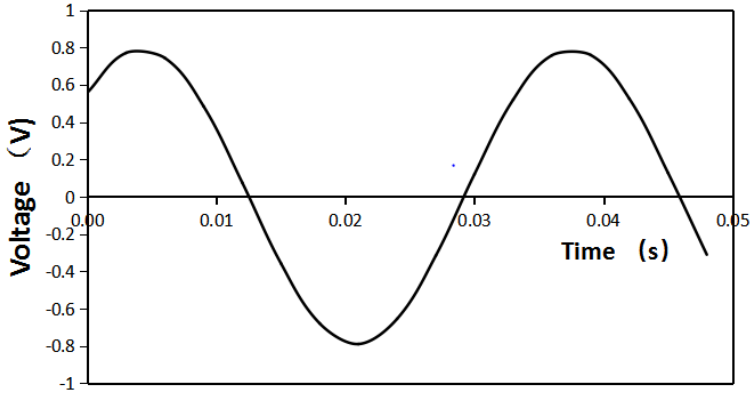
Figure 13. Energy supply experiment of Halbach array to different devices.